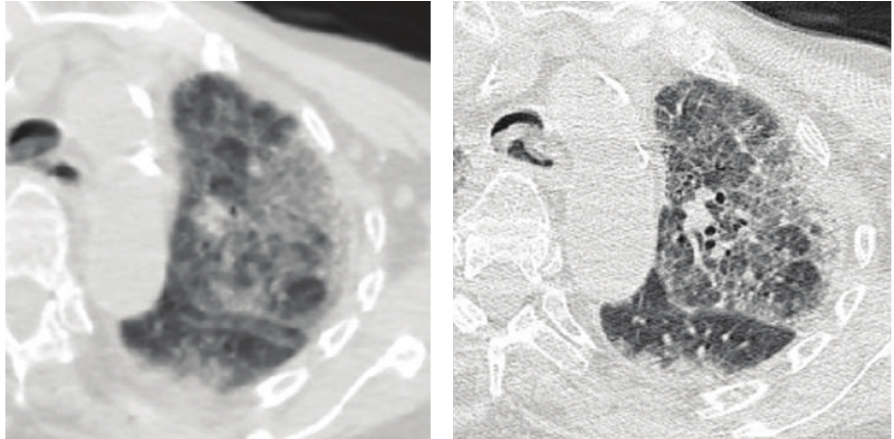
Figure 1: Motion artifacts due to breathing in an elderly patient impairing interpretation of the interstitial changes. An additional scan with the use of a standard high resolution technique is substantially improving diagnostic